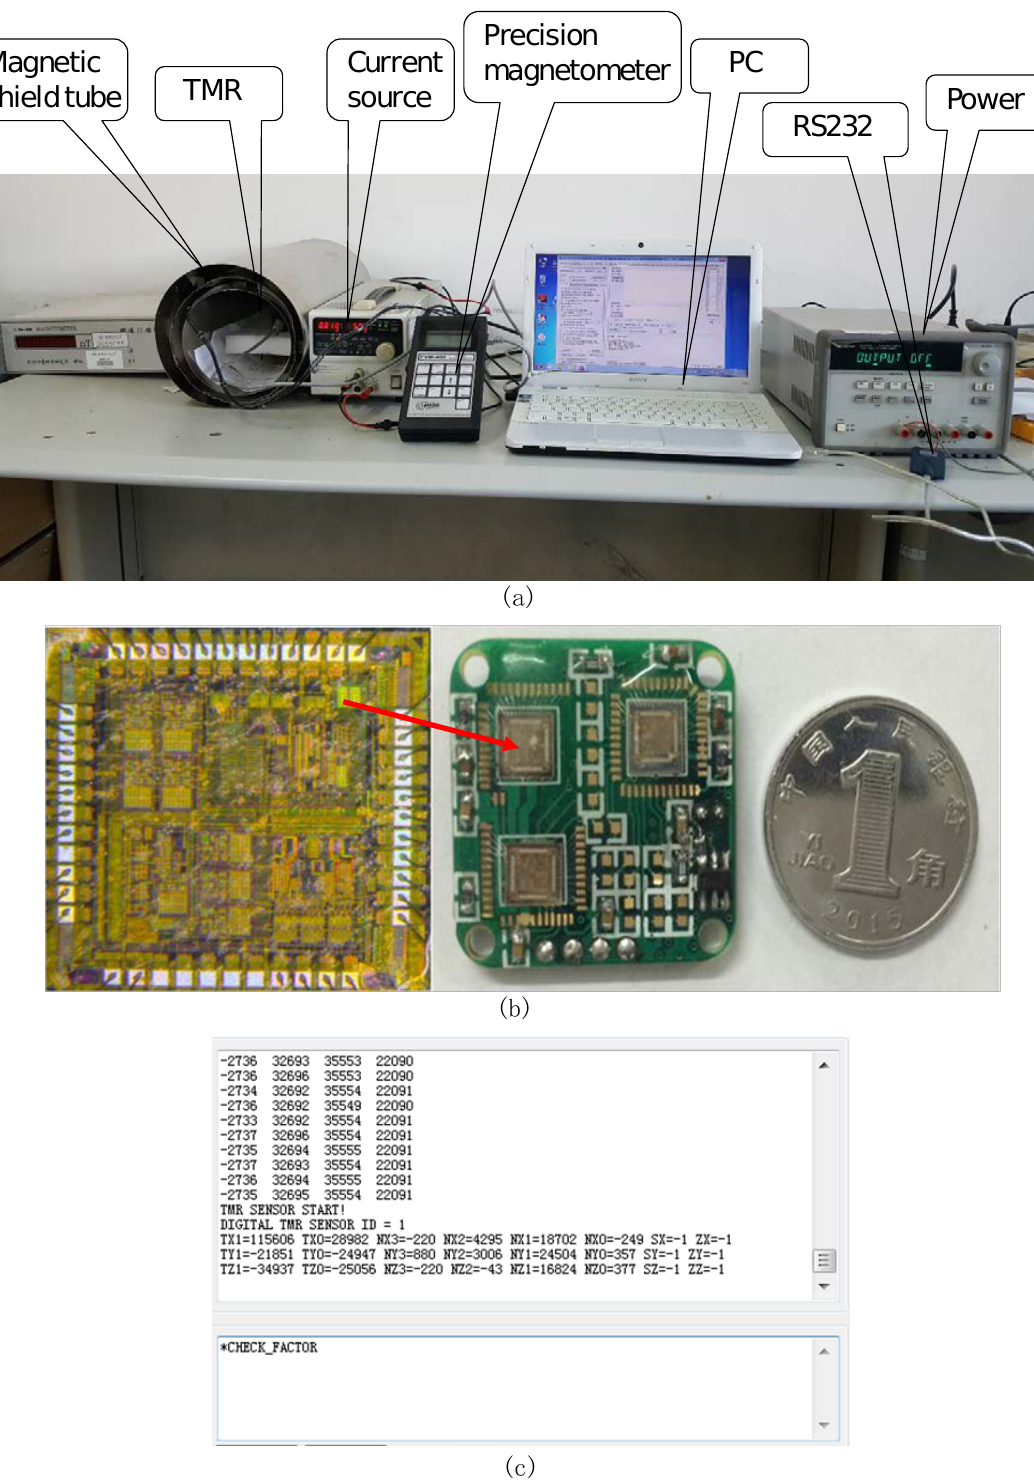
Figure 10. ( a ) The test platform of the three-axis digital magnetic sensor system ( b ) The photograph of printed circuit board (PCB) and ASIC chip ( c ) The data collection by RS232 in PC.